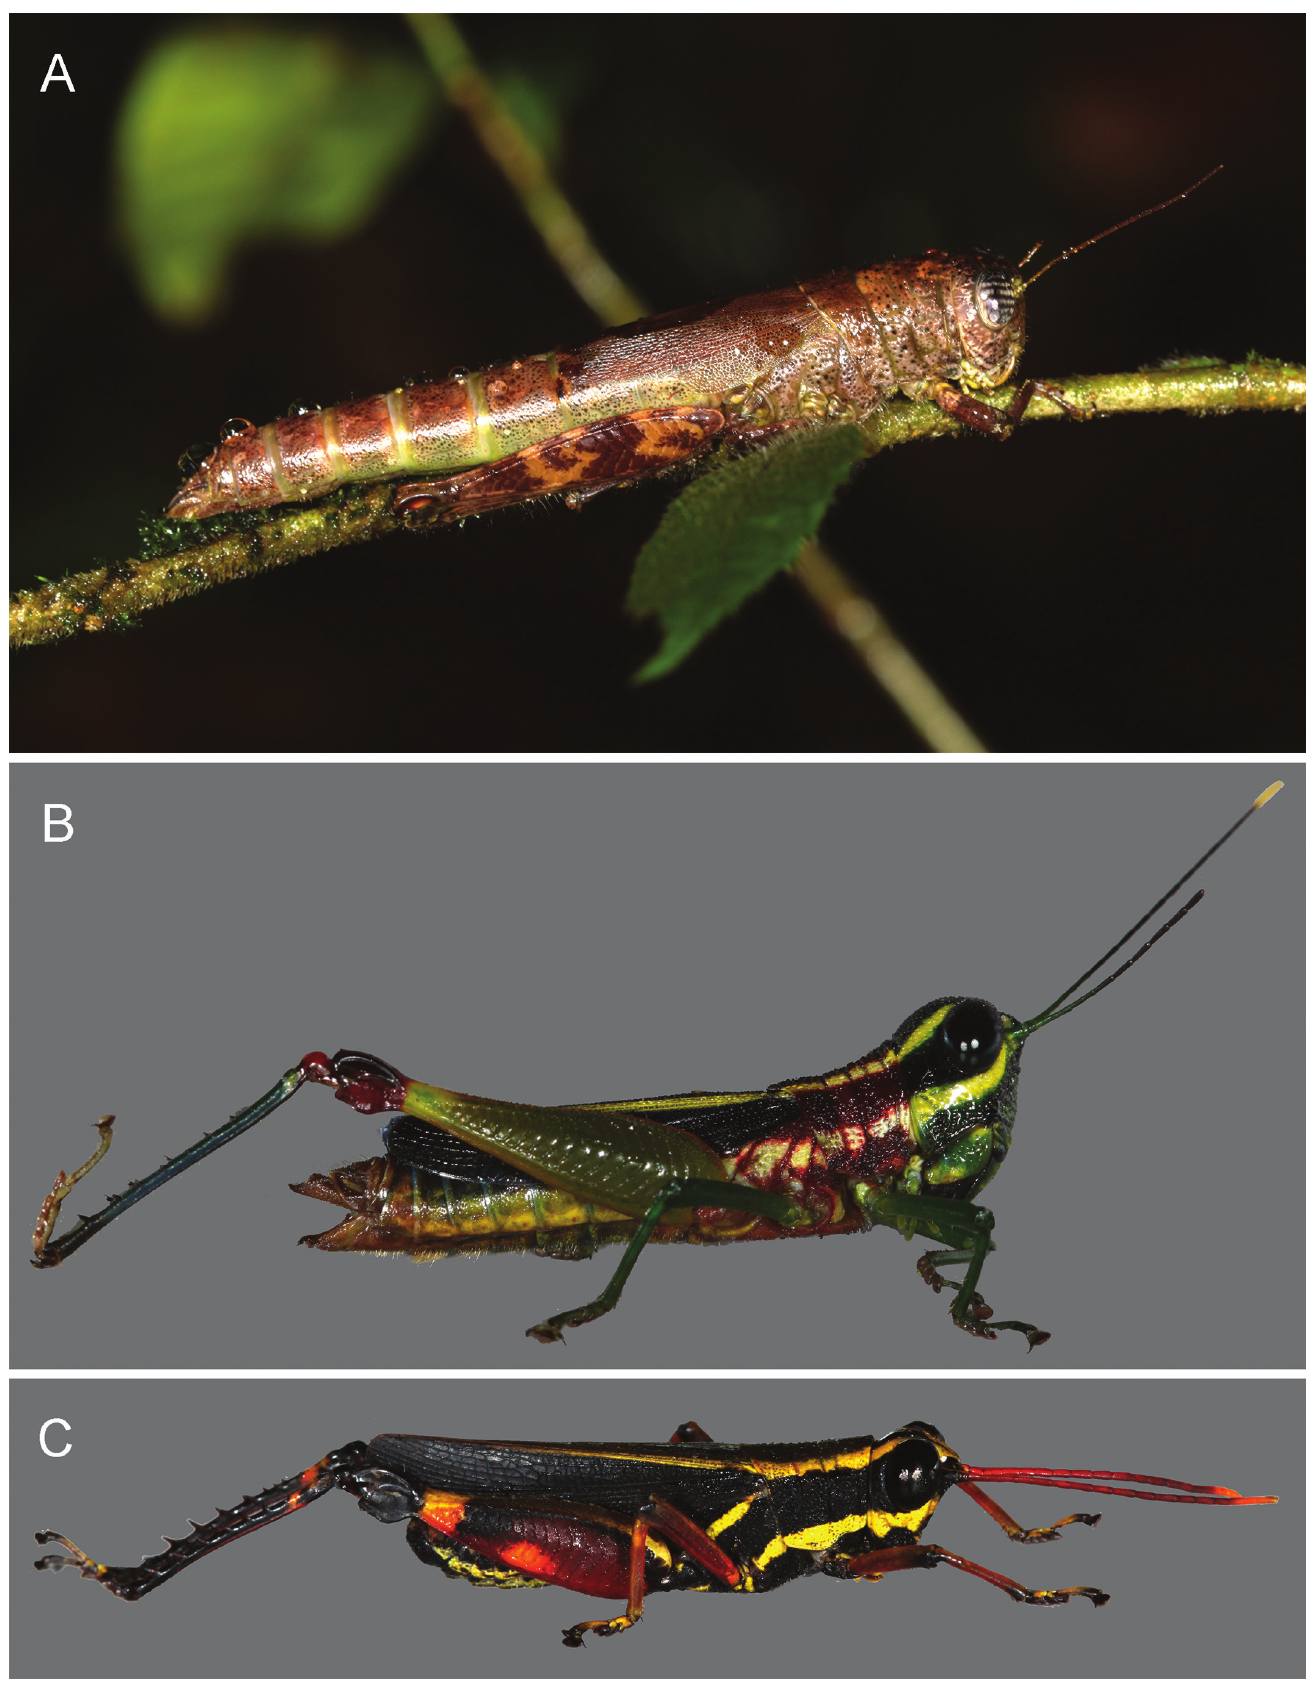
Fig. 4. Acrididae: A. Perakia nr. borneensis ; B. Traulacris sp.; C. Traulia borneensis